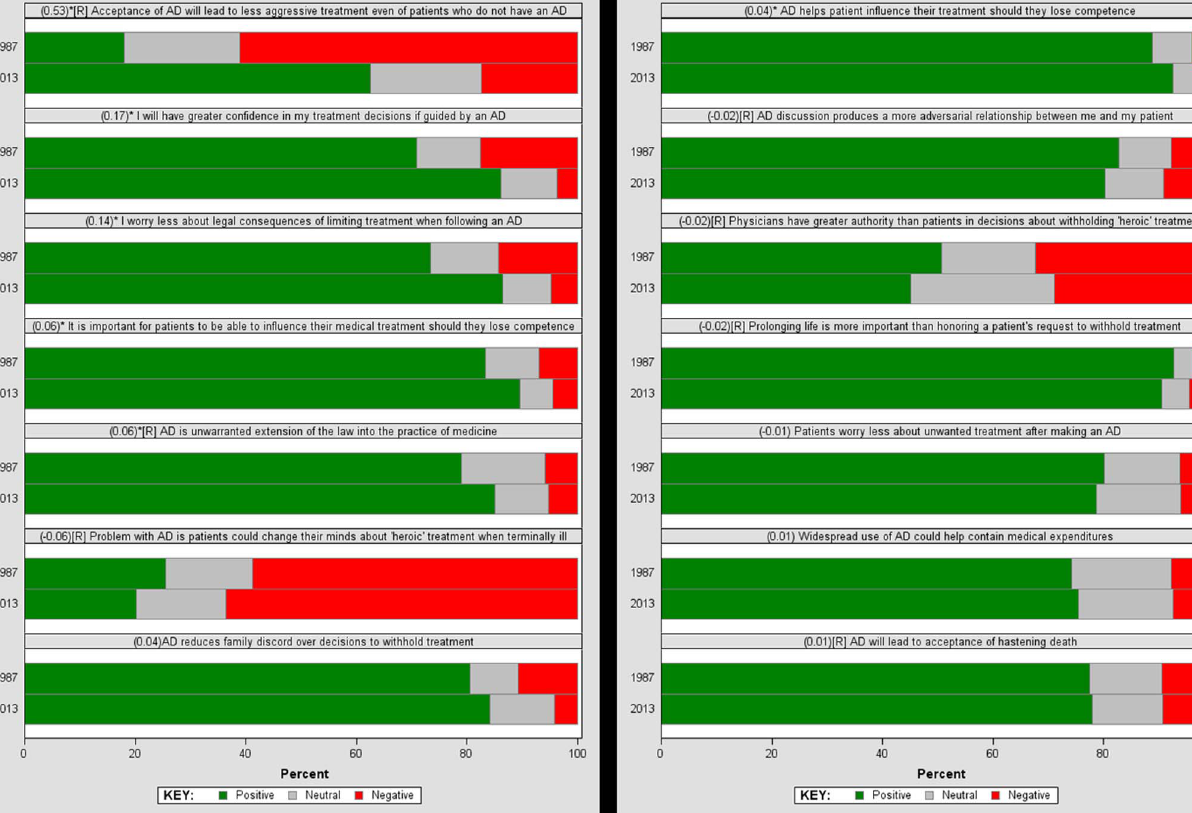
Figure 1. Comparison of the 1989 cohort to the 2013 cohort of doctors on each of the 14 statements about Advance Directives. Please note that ( ) indicates the Success Rate Difference Effect Size ( 2 1.0 to + 1.0). [R] indicates statements that oppose Advanced Directives. An asterisk sign* indicates the Mann-Whitney Wilcoxon test with the Bonferroni adjustment is significant at a =0.05/14.